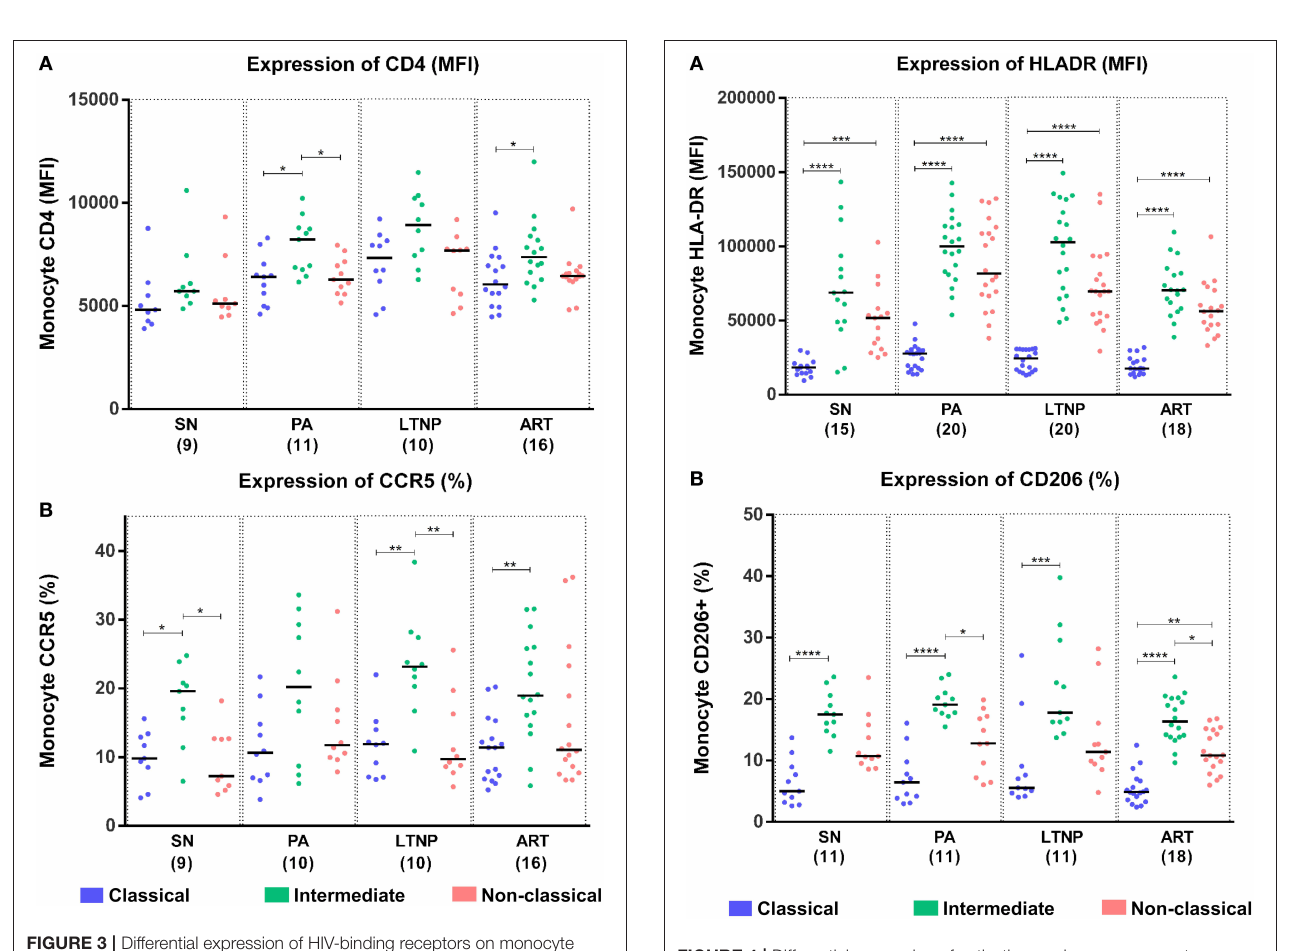
FIGURE 2 | in the LTNP group. (D,E) Correlation analyses of frequency of classical, intermediate and non-classical monocytes with CD4/CD8 ratio in PA ( n = 12) and LTNP ( n = 18) groups, respectively. Association between variables was evaluated by linear regression and Spearman correlation test was used to determine correlation co-efficient ( r ) and significance ( P < 0.05). (F) Comparison of CD4/CD8 ratios of therapy-naïve groups (PA and LTNP) with seronegative (SN) controls. Statistical significance was estimated by Kruskal-Wallis ANOVA followed by Dunn’s multiple comparison test; *** P < 0.001; **** P < 0.0001.